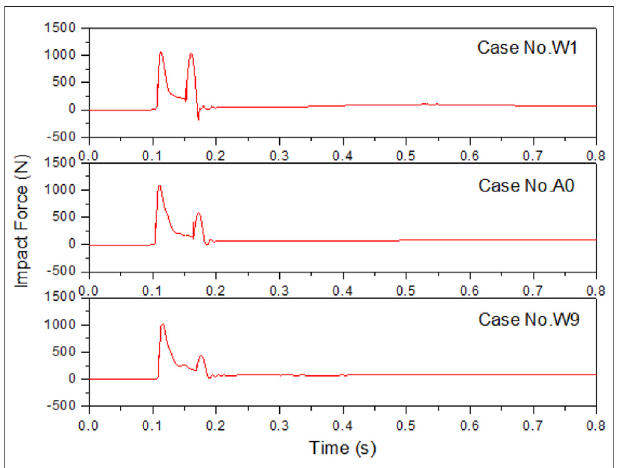
FIGURE 11 | The effects of holes location on the real-time impact force.